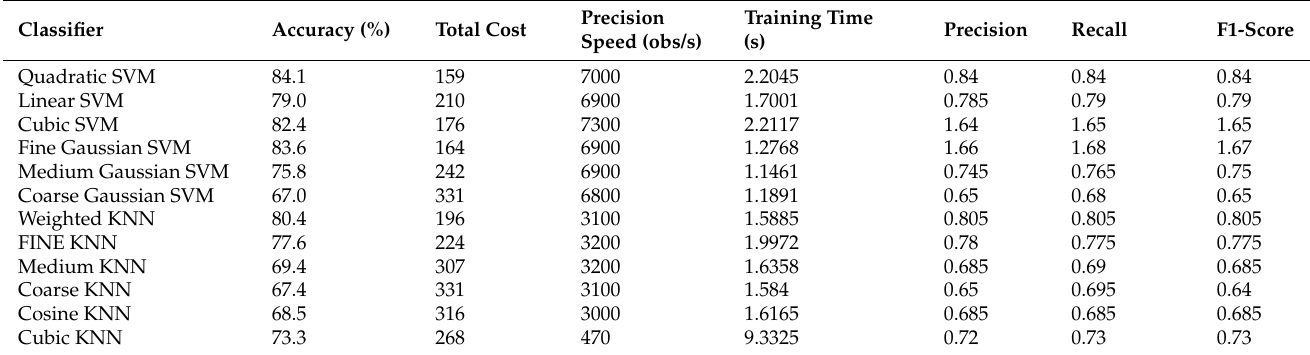
Table 8. Experiment_3 using 5 Folds (500 Feature).